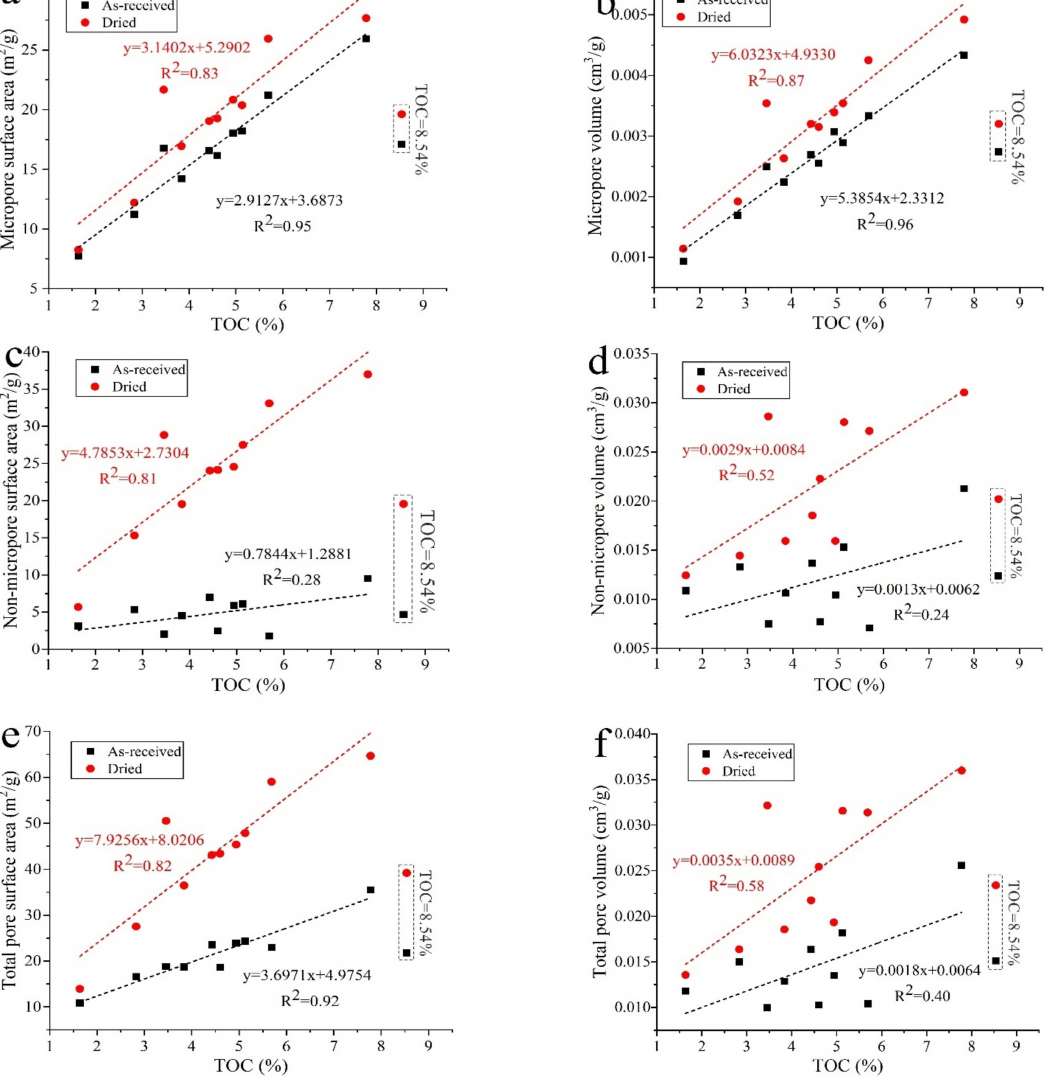
Figure 6. Correlations of pore surface area ( a , c , e ) and volume ( b , d , f ) with the TOC content of the deep shale samples in the Luzhou